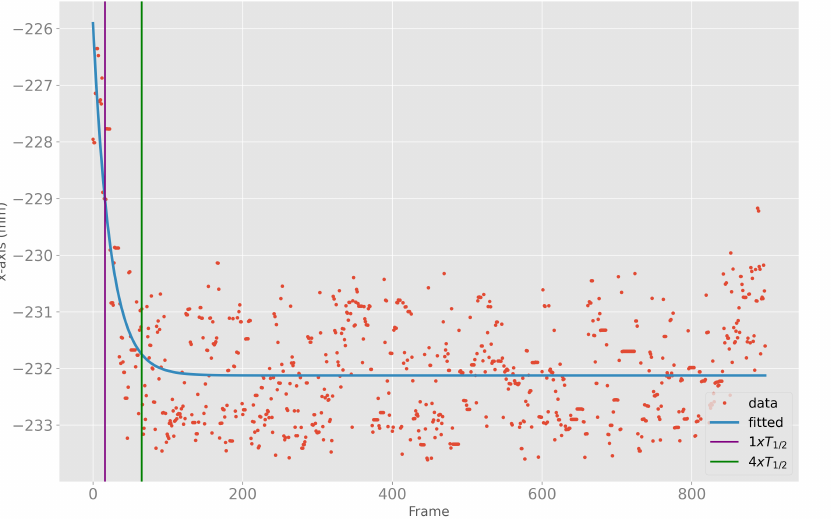
Figure 4. X -position data (red) of ELBOW_RIGHT, fitted exponential curve (blue), as well as one (purple) and four (green) times the half-life time of the fitted exponential